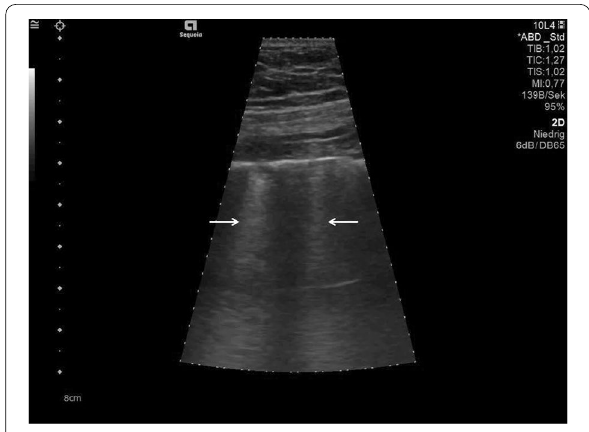
Fig. 3 Examination of the lung using a curved array probe, detecting single C-lines (white arrows), they come out of tiny